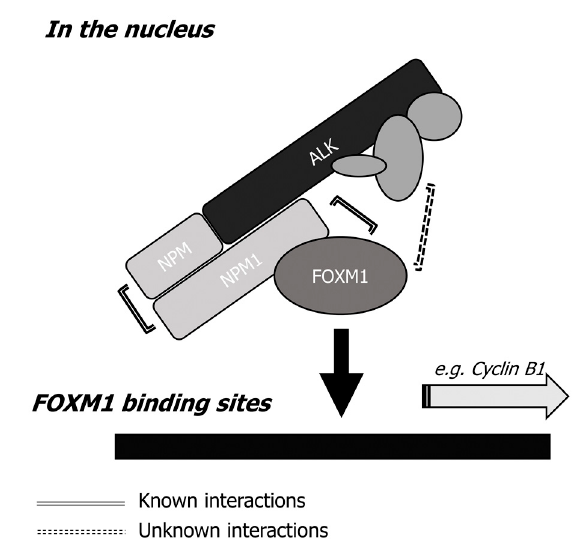
Figure 8. Diagram showing the binding interaction between NPM-ALK and FOXM1. NPM-ALK binds to FOXM1 through mutual interactions with a segment of NPM1, which is not represented in the NPM-ALK fusion protein. The phosphorylation of NPM-ALK further potentiates its ability to bind to FOXM1 and influence FOXM1 transcriptional activity. One possible mechanism is that phosphorylated NPM-ALK is bound by a host of other proteins, which may promote the binding between NPM-ALK and FOXM1.